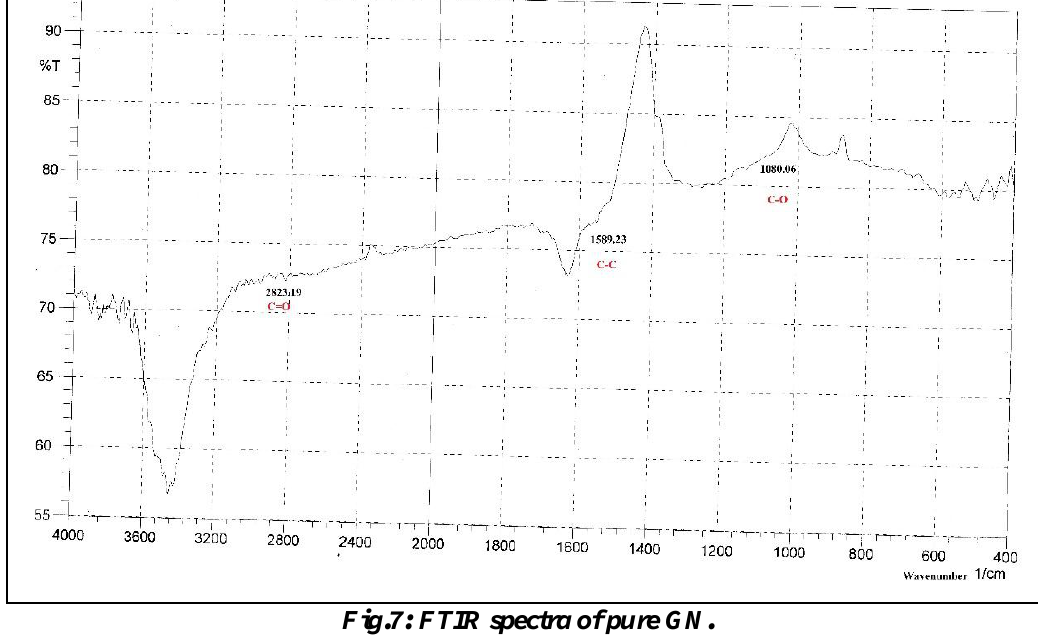
Fig.7: FTIR spectra of pure